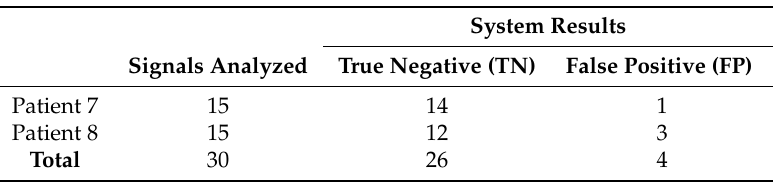
Table 4. Results of patients who do not have episodes of FOG.